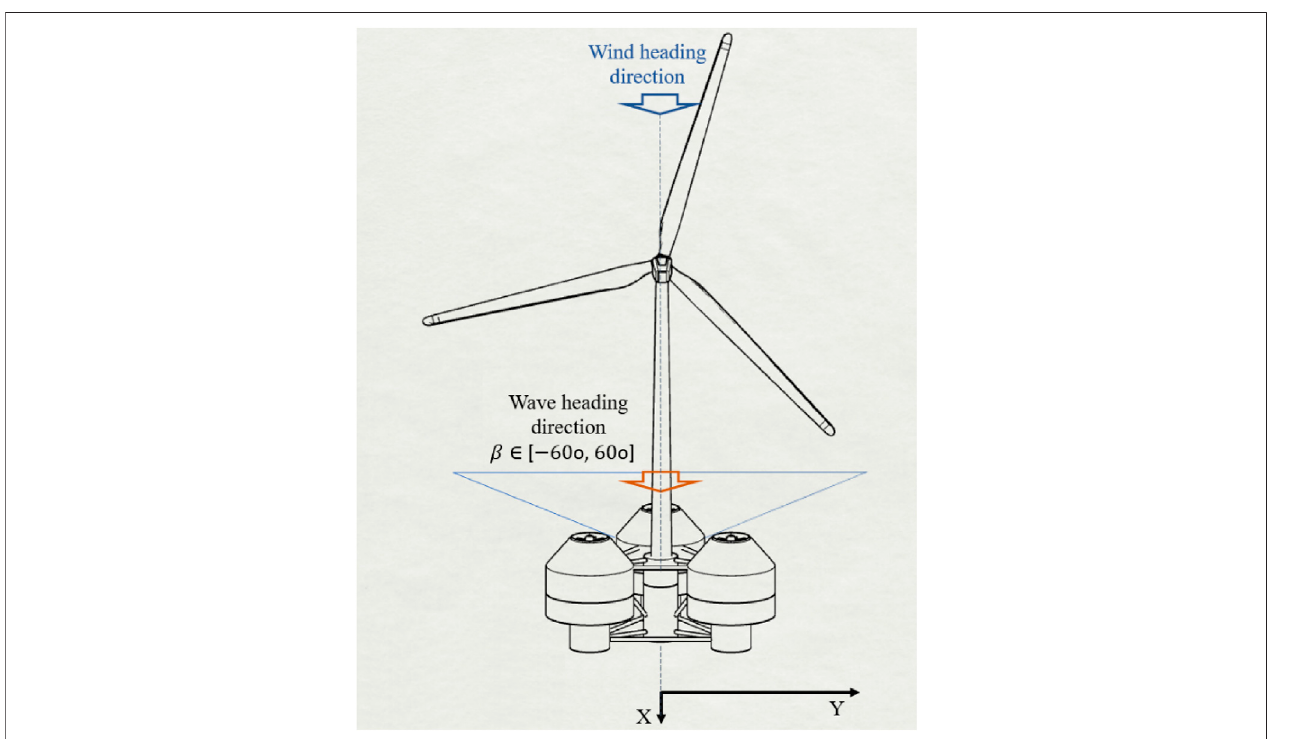
FIGURE 4 | 3D de fi nition sketch of the examined wind and wave heading